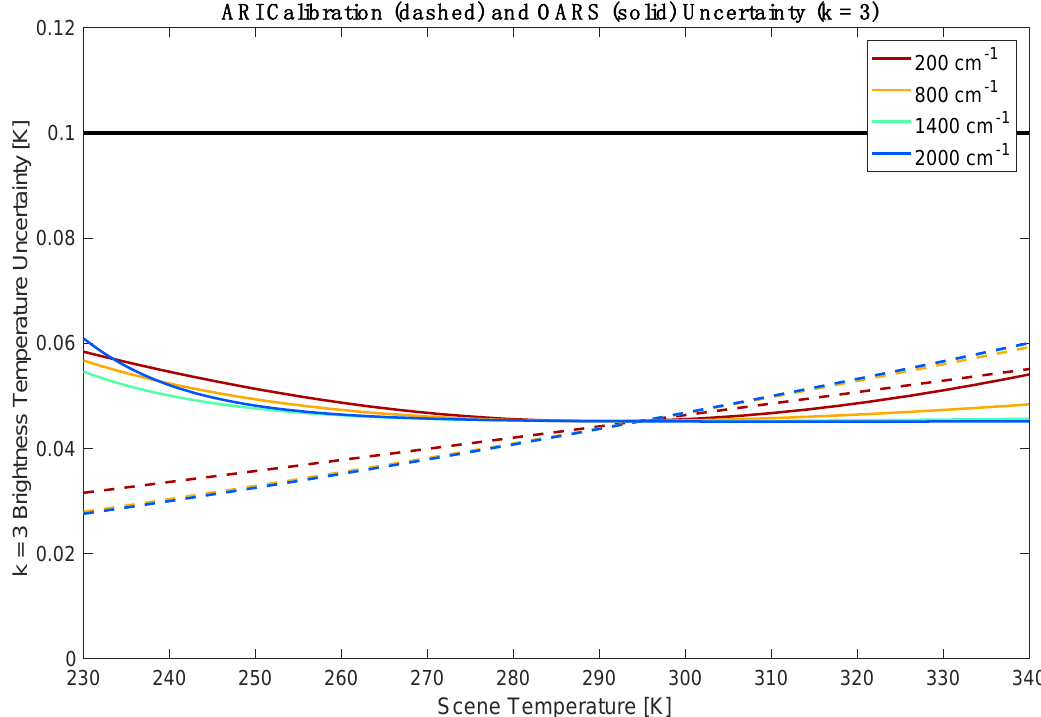
Figure 5. Predicted on-orbit radiometric calibration uncertainty (dashed) and calibration verification source uncertainty (solid) (k = 3).